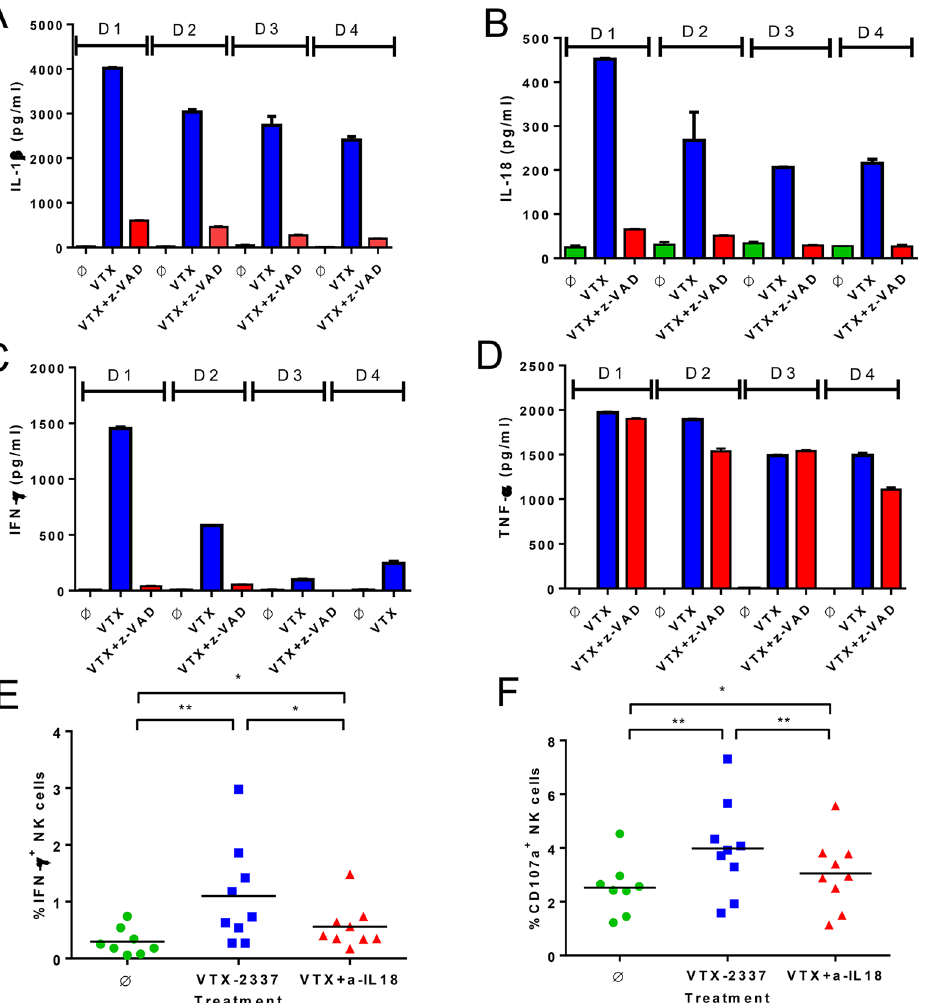
Fig 4. Caspase-1 activation and IL-18 induction by VTX-2337 leads to NK cell activation. (A-D) The effects of caspase-1 inhibition on IL-1 β , IL-18, IFN γ , and TNF α production by PBMC. Duplicate PBMC cultures from four healthy donors (indicated as D1, D2, D3 and D4) were treated overnight with medium ( Ø ), VTX-2337 (1 μ M), or VTX-2337 plus z-VAD-FMK (10 μ g/ml). Levels of IL-1 β , IL-18, IFN γ , and TNF α in culture supernatant were measured by ELISA. (E-F) The effects of IL-18 blockade on VTX-2337-induced IFN γ and CD107a expression in NK cells. Summary graphs show the percentage of IFN γ + and CD107a + NK cells from PBMC cultured with medium ( Ø ), VTX-2337 (0.5 μ M), or VTX-2337 and anti-IL18 neutralizing antibody (20 μ g/ml) for 9 donors where each symbol represents one individual donor. The horizontal bar represents group the mean for the treatment. Data shown are the summary of four independent experiments from the 9 donors, * , p < 0.05 by Wilcoxon signed-rank